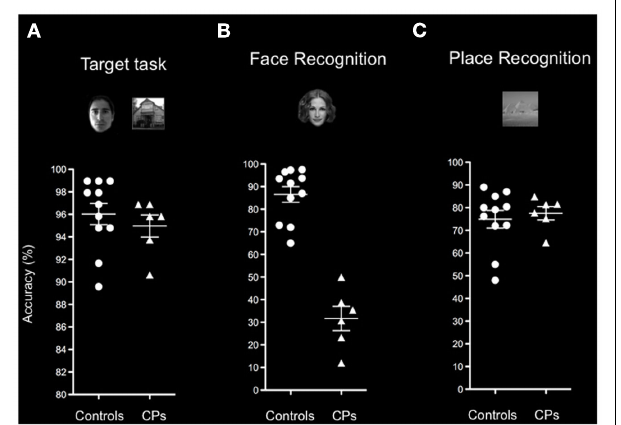
FIGURE 3 | Behavioral performance of healthy controls and participants with CP on the (A)Target detection task, (B) Face recognition block, and (C) Place recognition block of the Picture recognition task. Indicated are means and SEM. Results show that CPs (triangles) and controls (circles) show similar accuracy on theTarget detection task and on the Place block of the Picture recognition task.The two groups differ in their ability to recognize familiar faces as shown on the Face block of the Picture recognition